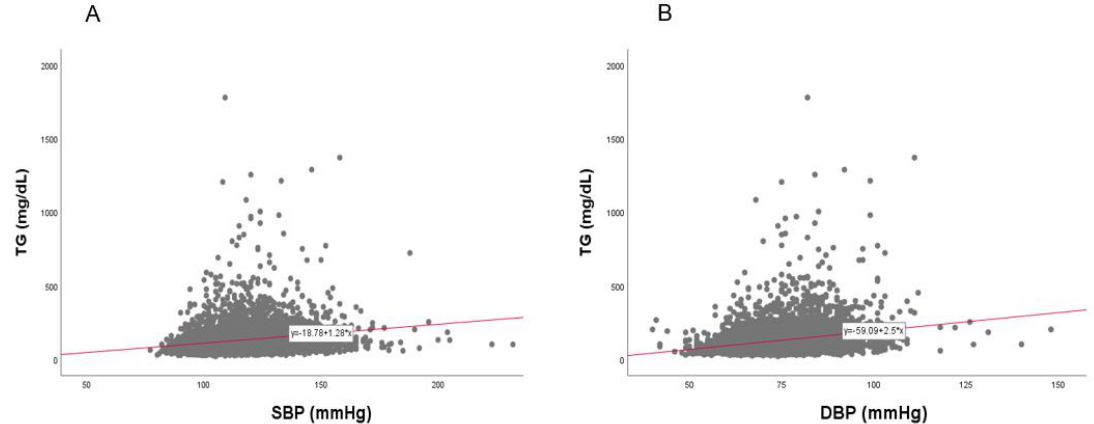
Figure 14. Pearson’s correlation analysis between triglyceride (TG) and systolic blood pressure (SBP, panel A ) and diastolic blood pressure (DBP, panel B ) in total population ( n = 4552). Panel A showed a positive correlation (r = 0.192, p < 0.001) between SBP and TG; Panel B showed a positive correlation (r = 0.240, p < 0.001) between DBP and TG.